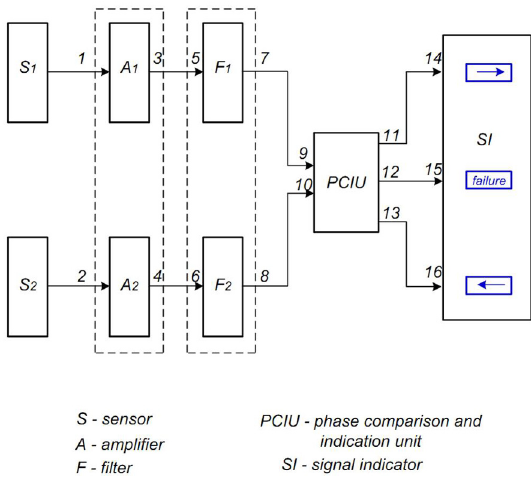
Figure 8. View of Sensors and Measuring Rod.